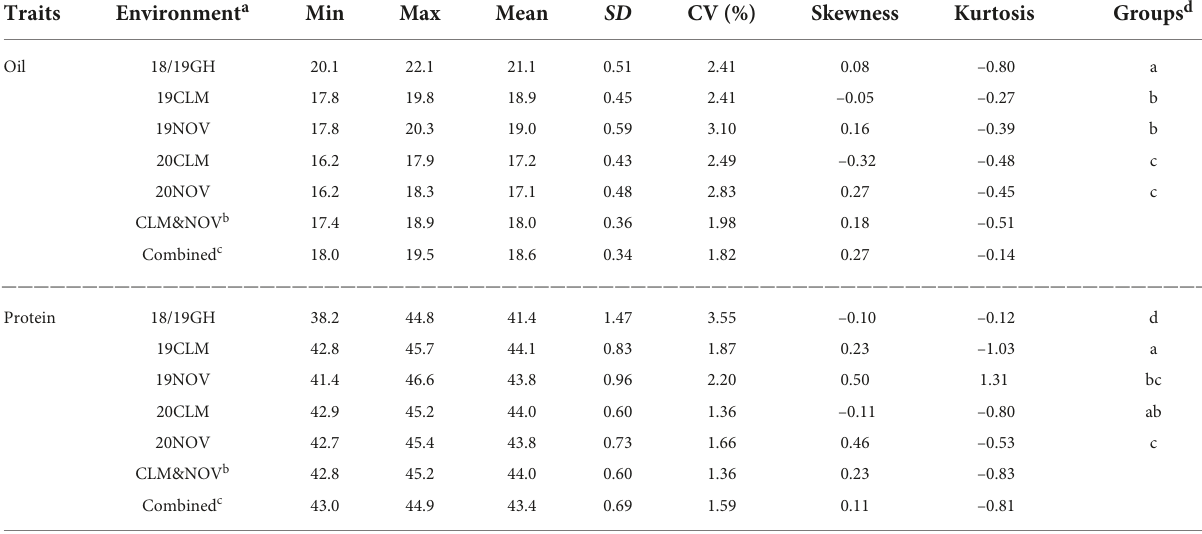
TABLE 2 Descriptive statistic of minimum, maximum, means, standard deviation (SD), coefficient of variation (CV), skewness, kurtosis, and least-square means of seed oil and protein between environments. Traits